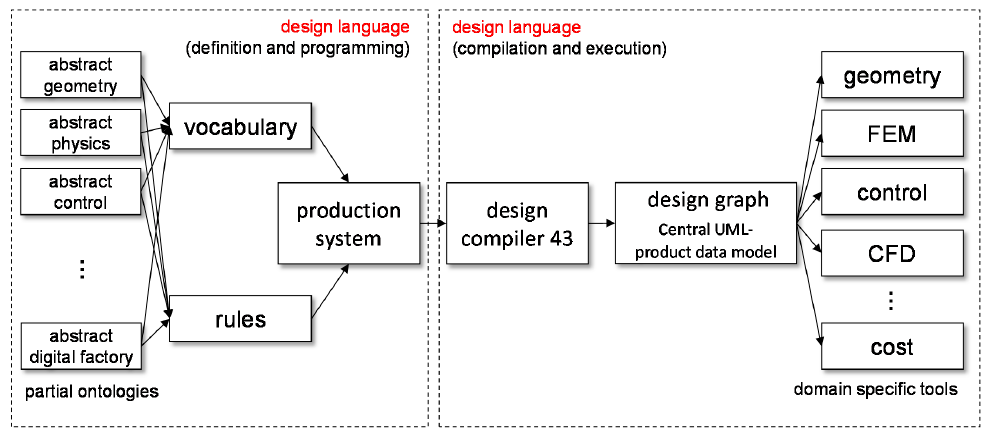
Figure 7. Application of a graph-based design language (compare Rudolph [44]).